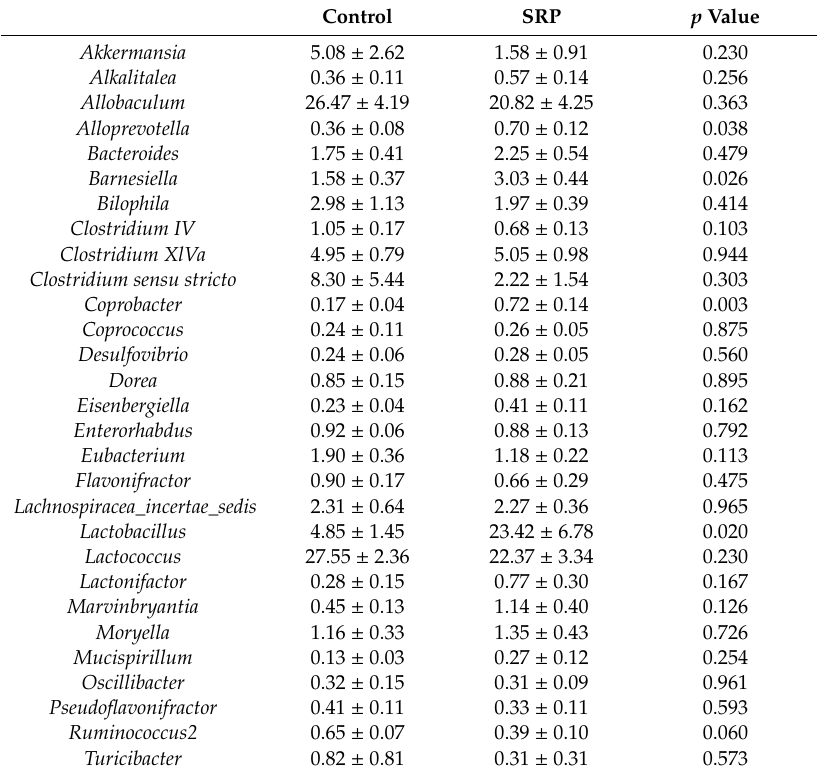
Figure 3. Gut microbiota analyzed by 16S rRNA gene sequencing using feces of mice fed a control diet (control) and a diet with sake cake and rice malt (SRP) for four weeks. ( A ) The composition of gut microbiota at the phylum level. ( B ) Significantly different taxa at the family level. Data are shown as the mean ± SEM ( n = 7). * p < 0.05. Table 4. Genus level taxonomic distributions of the microbiota in the